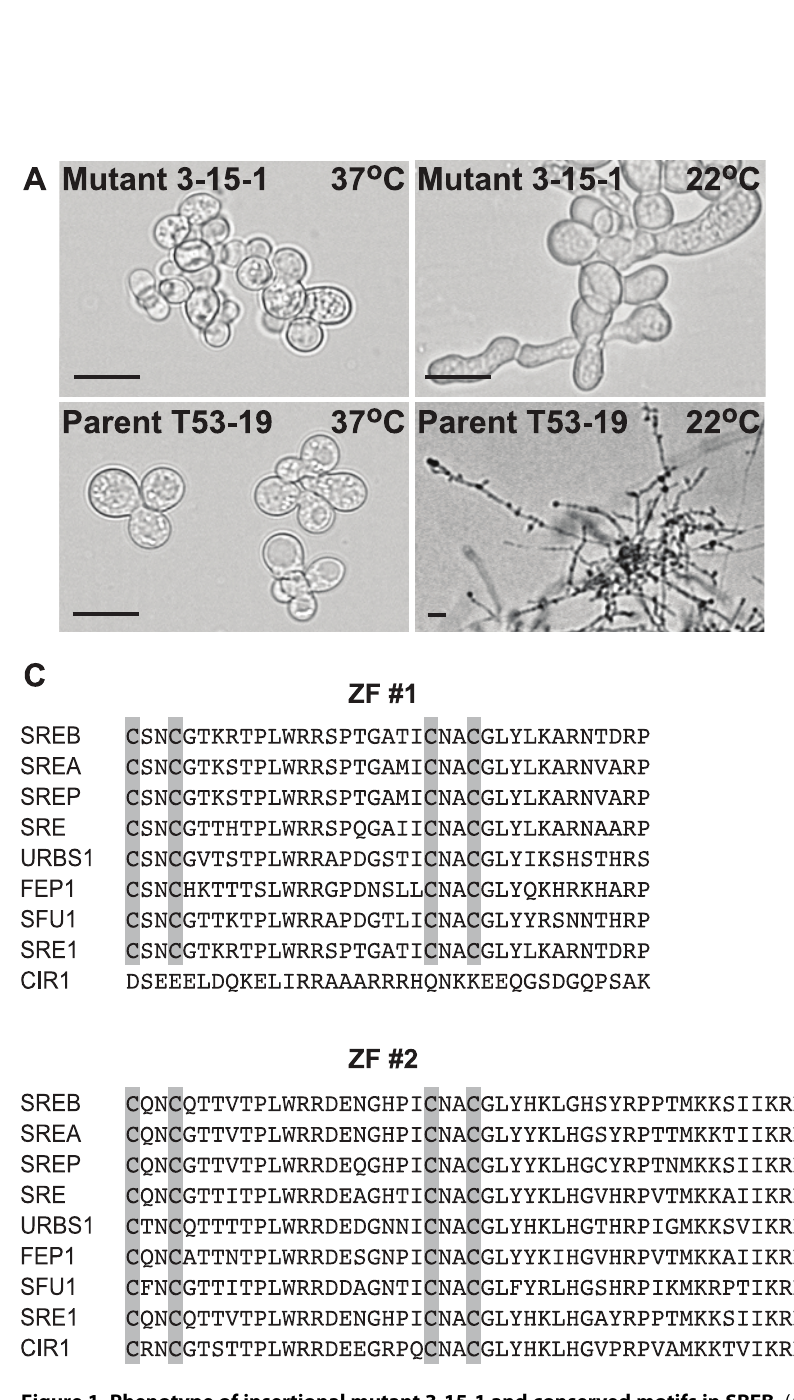
Figure 1. Phenotype of insertional mutant 3-15-1 and conserved motifs in SREB. ( A ) Insertional mutant 3-15-1 failed to convert from yeast to mold after 14 days of incubation at 22 u C. Parent strain T53-19 converted from yeast to mycelia within 7 days of shifting the temperature from 37 u C to 22 u C (Scale bar equals 20 m m). ( B ) Mutant 3-15-1 developed a yellow pigmentation and discolored the surrounding 7H10 medium, which contains 150 m M FeSO 4 . In contrast, T53-19 grew as white-colored yeast and did not pigment the medium. ( C ) The predicted amino acid sequence of B. dermatitidis SREB is aligned with A. nidulans SREA, P. chrysogenum SREP, N. crassa SRE, U. maydis URBS1, S. pombe FEP1, C. albicans SFU1, H. capsulatum SRE1, and C. neoformans CIR1. SREB contained several conserved domains including two zinc fingers (ZF # 1, ZF # 2) separated by a cysteine-rich region (CRR) and a conserved C-terminus (CCT) with a predicted coiled-coil domain. Conserved cysteine residues in ZF # 1, ZF # 2, and CRR are highlighted. ClustalW (1.81) was used to align the amino acid sequences. GeneBank accession numbers include AAD25328 (SREA), AAC49628 (SREP), AAC64946 (SRE), AAB05617 (URBS1), AAM29187 (FEP1), XP_723364 (SFU1), ABY66603 (SRE1), and ABG21303 (CIR1).